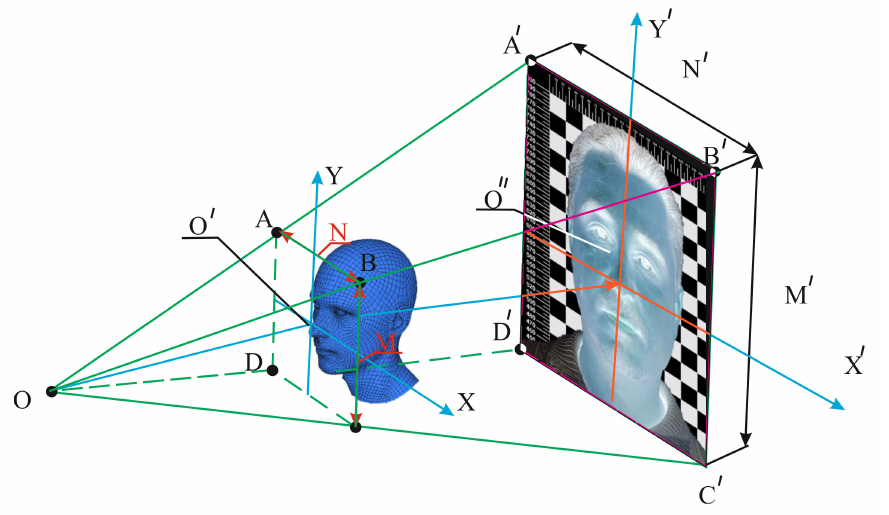
Figure 2. Scheme of a person’s face size